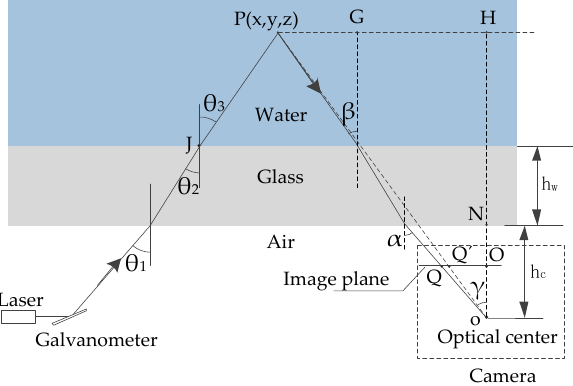
Figure 5. A planar view of the working system and the refraction caused by the air-glass-water interface of the incident and reflected light.